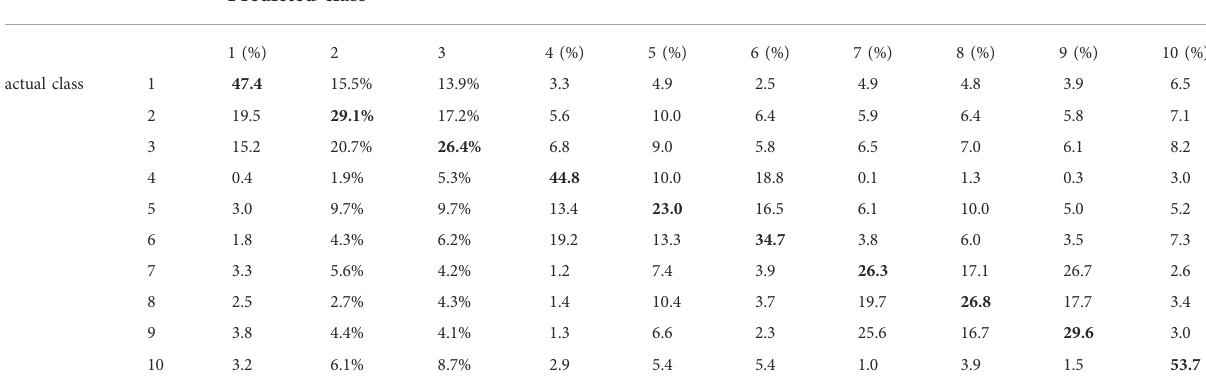
TABLE 5 Error matrix of the random forest classi fi er for the pseudo-polarimetric Sentinel-1 data. Predicted